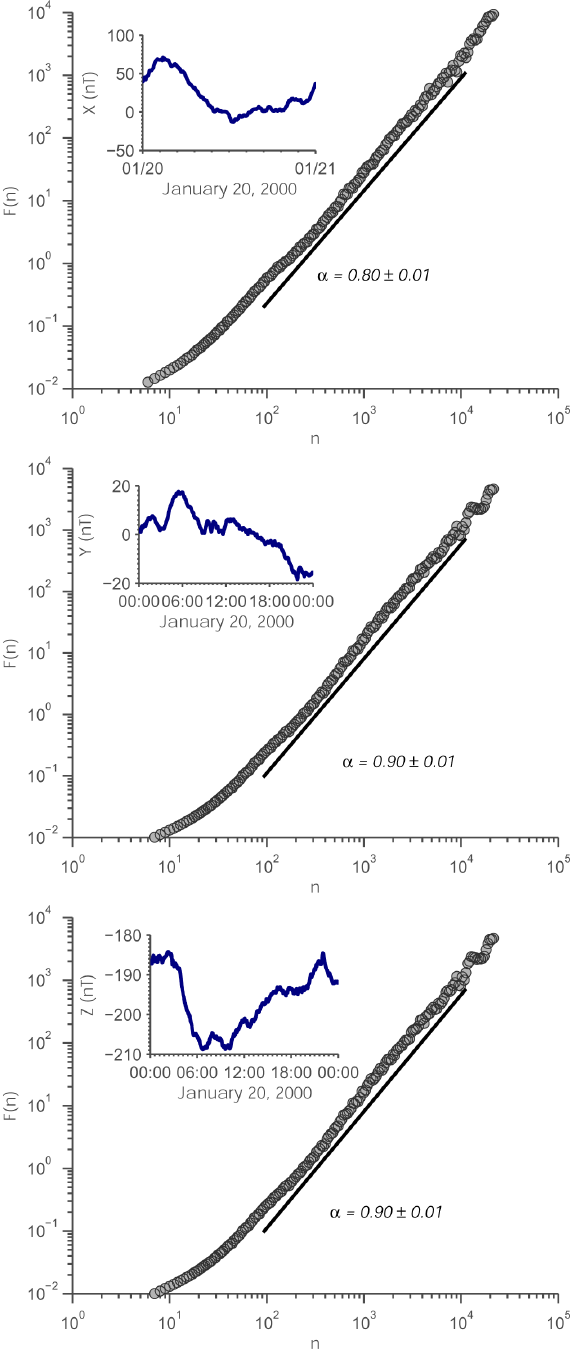
Fig. 3. Circles show an example of the fluctuation versus box size for the quiet event beginning on 20 January 2000. Solid curve below the circles is the best fit linear curve to the data (shifted) and slope α is shown on each graph. The inset in this example shows the com- ponent magnetometer data from the BIK station used to compute the fluctuation curves.